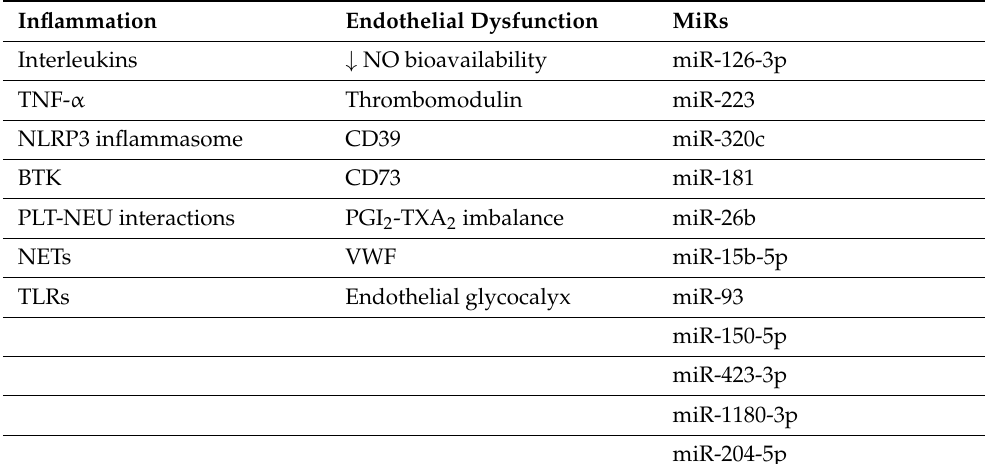
Table 1. Potential inflammatory, endothelial, and miR mediators of platelet activation. Inflammation Endothelial Dysfunction MiRs